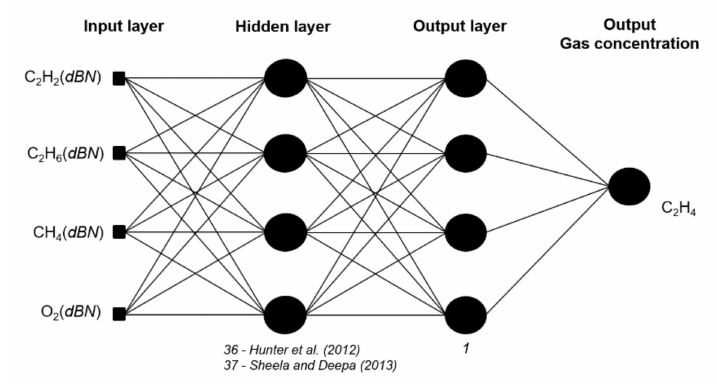
Figure 2. Gas concentration C 2 H 4 decomposed by Wavelet db2 to db20.